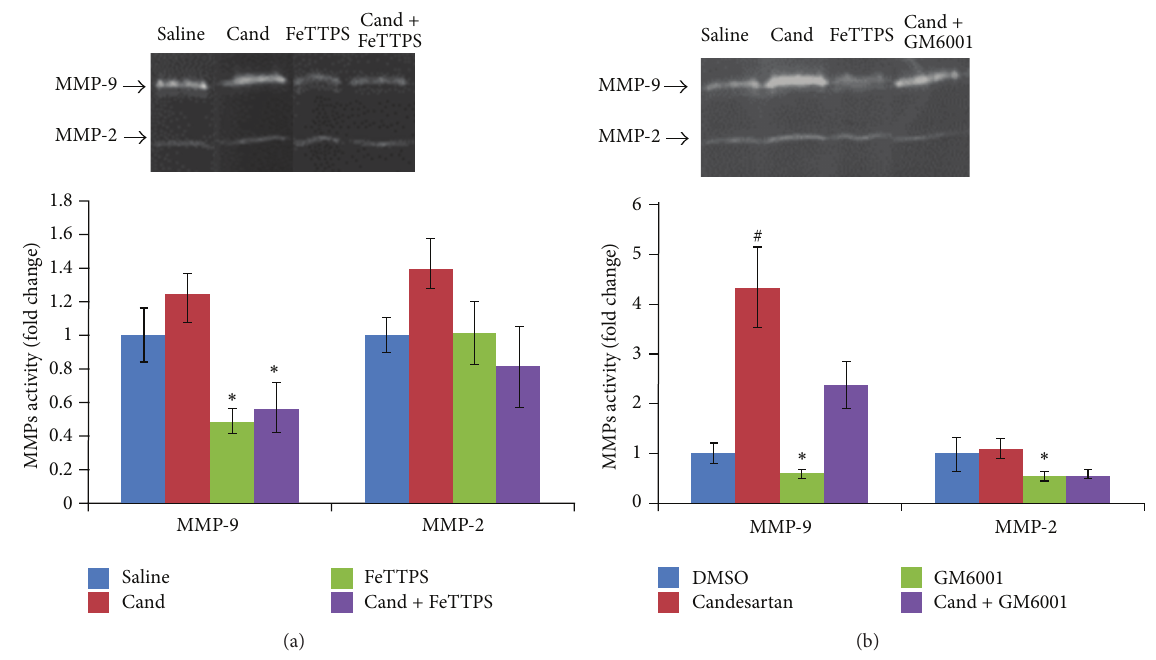
Figure 2: Effects of candesartan alone and in combination with FeTPPS and GM6001 on MMP activity at 24 h after MCAO. MMP-9 was significantly inhibited by FeTTPS alone and in combination with candesartan. Candesartan alone significantly increased MMP-9 when administered with DMSO, but GM6001 significantly reduced MMP activity. Values are mean ± SEM ( # 𝑃 < 0.05 , ∗ 𝑃 < 0.05